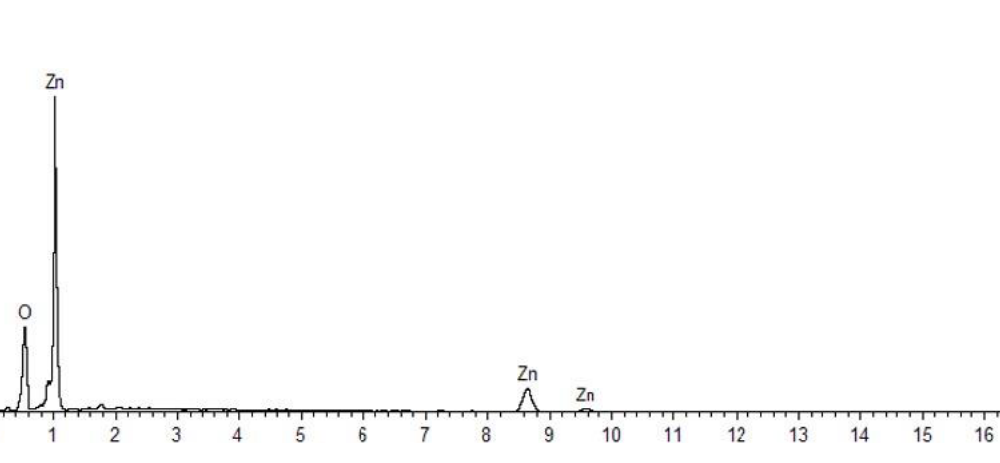
Figure 4. Energy-dispersive X-ray spectrum of ZnO NPs synthesized without heating (28 °C).